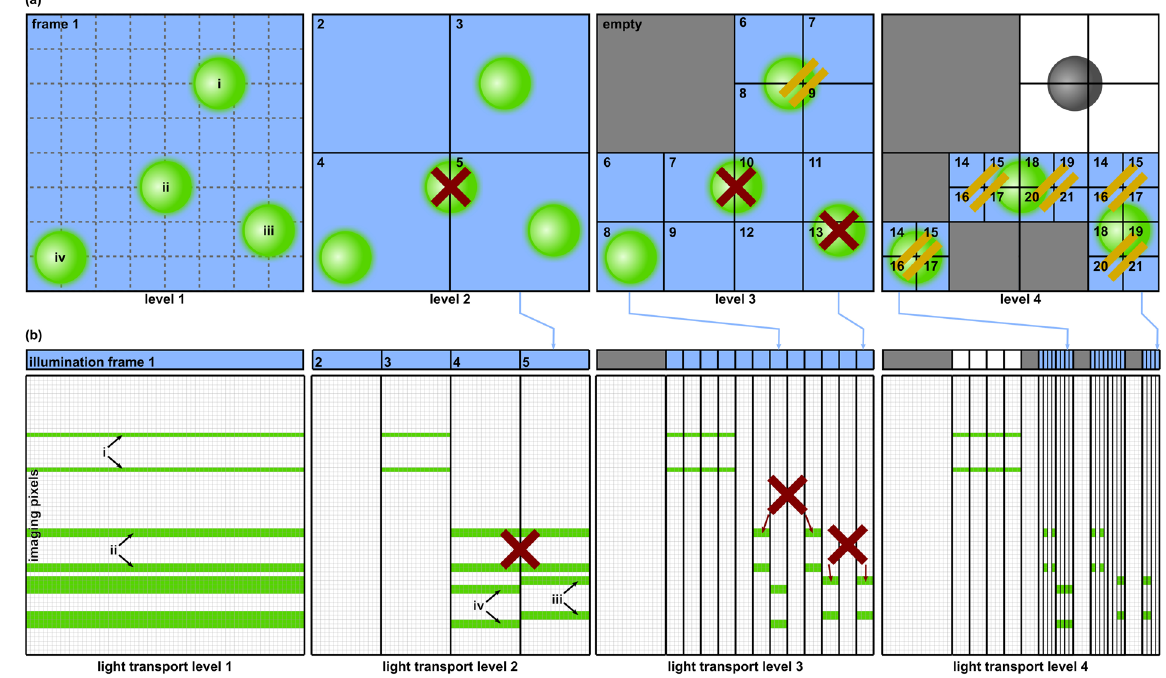
Figure 1. Our algorithm illustrated by a simplified 2D example with four isotropic particles (i to iv). ( a ) Top view of hierarchical illumination levels. We start by recording a frame under full illumination that is subdivided recursively. Non-conflicting frames recorded in parallel are denoted by the same frame number. Illumination rays that cause blank recordings are rejected (indicated by grey color). ( b ) Estimated versions of the light-transport matrix (64 × 64) after scanning through various levels. Conflicts are detected, and our isotropy hypothesis is applied at each level. Rows in the matrix correspond to recorded imaging rays, while columns are related to illumination rays. Emission signatures of particles (i.e., rows in the light transport) are indicated in green. Conflicts are marked by crosses, while isotropic similarities are marked by two diagonal bars. Illumination of particle i is stopped after 3 subdivision levels due to isotropic emission. Overall, the algorithm stops after scanning four hierarchical levels in the example